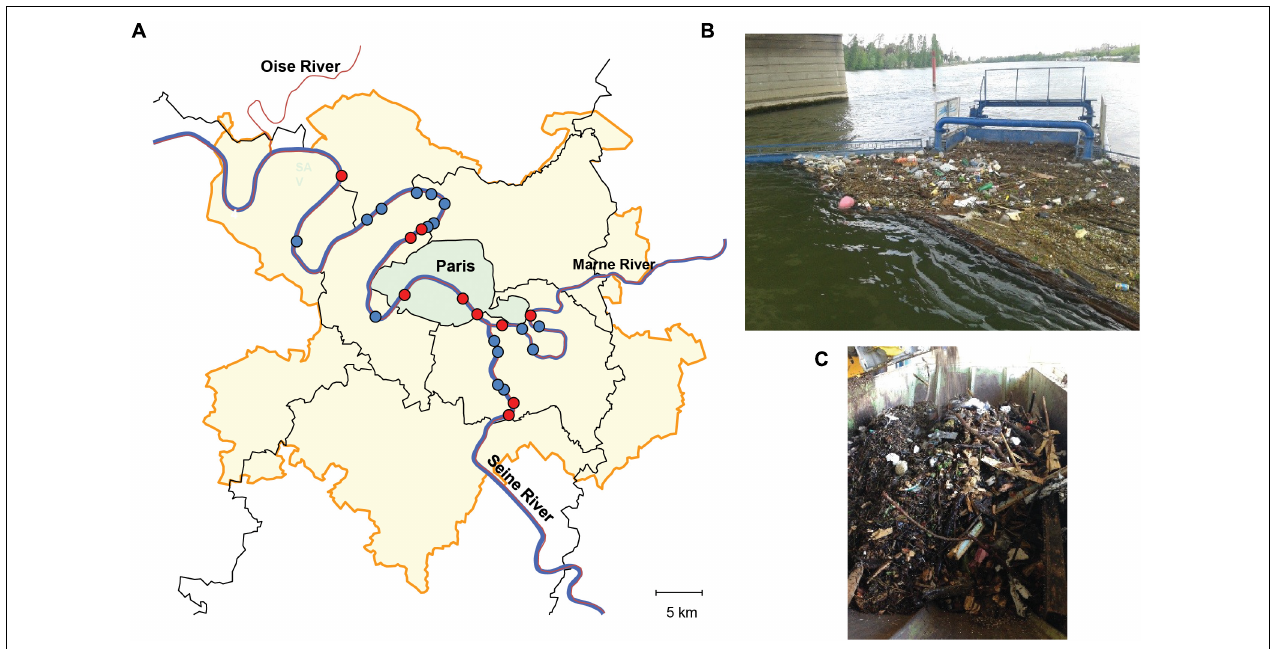
FIGURE 2 | (A) Geographical distribution of the floating boom network from SIAAP in Paris megacity with sampled booms by Gasperi et al. (2014) in red, (B) a picture from a floating boom and (C) an example of waste removal by boat. Modified from Gasperi et al.